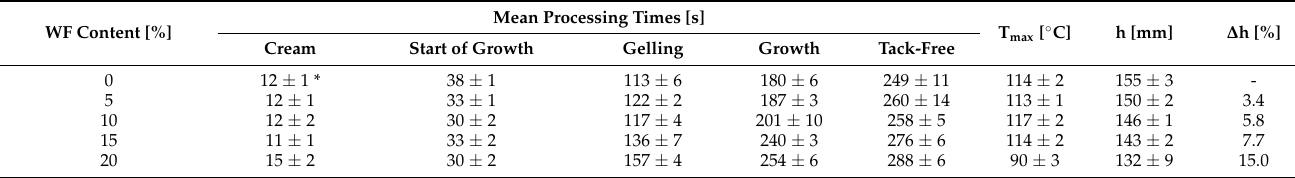
Table 1. Parameters characterising the foaming process of PUR/WF foams.